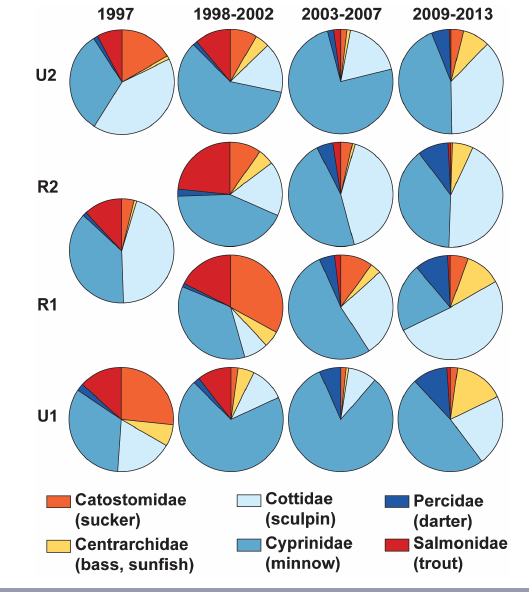
Fig. 3 . Fish family relative abundance for prerestoration (1997) and 5-year increments postrestoration to show change through time. R2 and R1 were sampled as one unit within the previous (abandoned) channel prior to restoration.